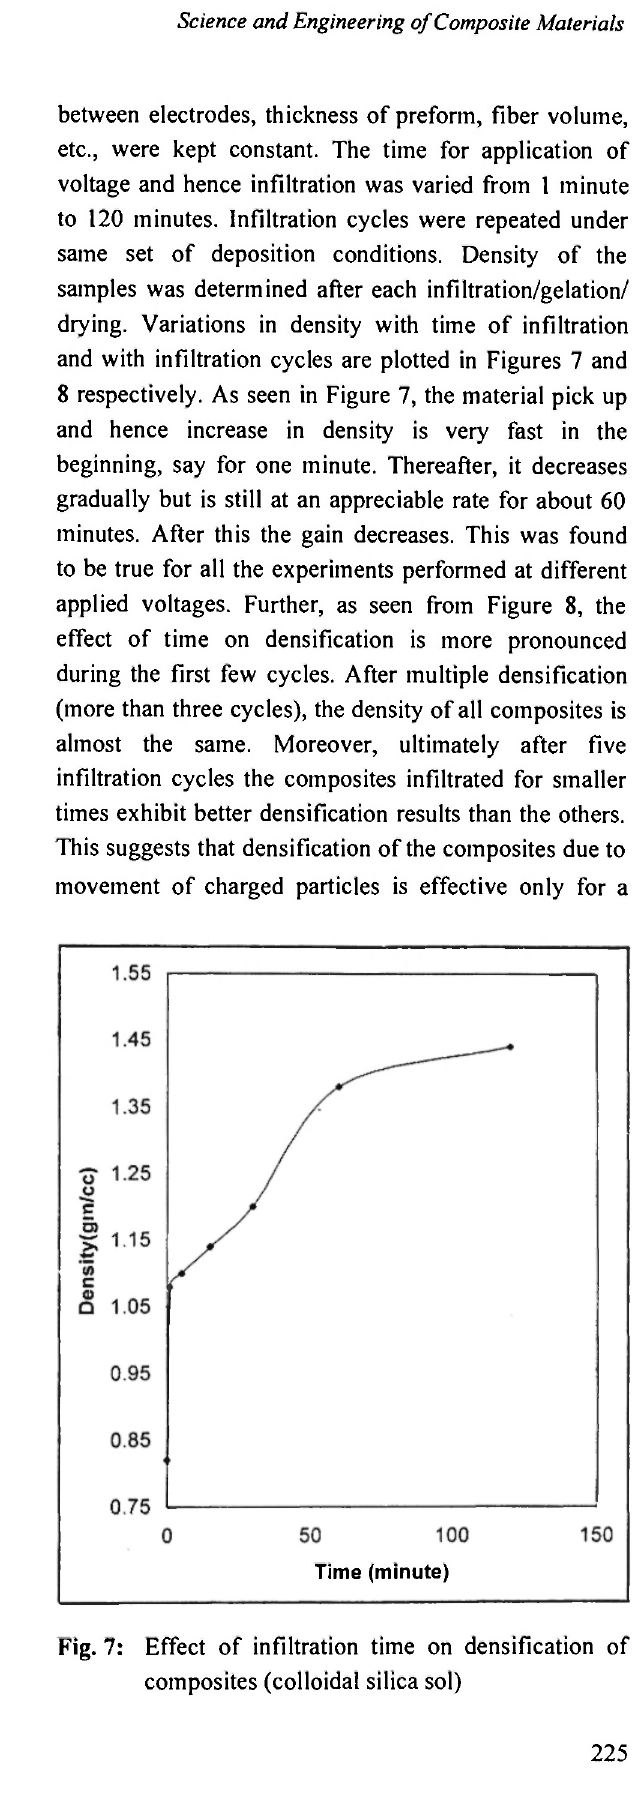
Fig. 7: Effect of infiltration time on densification of composites (colloidal silica